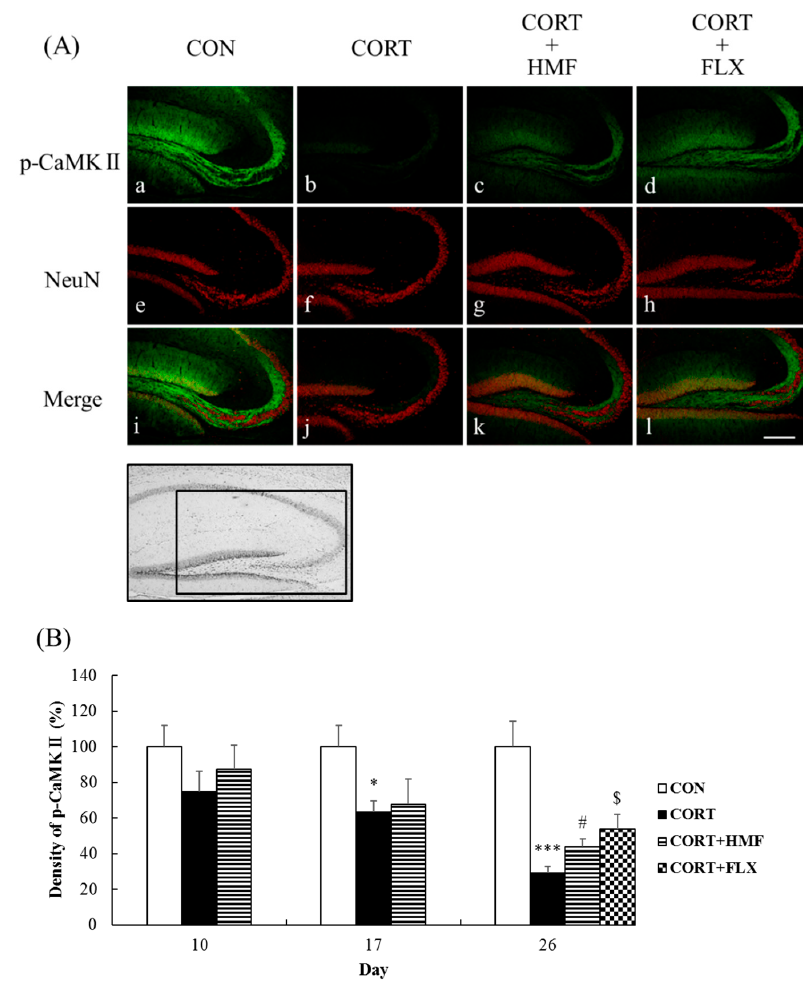
Figure 6. Effects of HMF on the expression of phosphorylated CaMK II and NeuN immunoreactivity continuous corticosterone injections were stained with specific antibodies, either anti-phospho-CaMK II (green; a, b, c, d) or anti-NeuN (red; e, f, g, h). Each signal was merged in i, j,